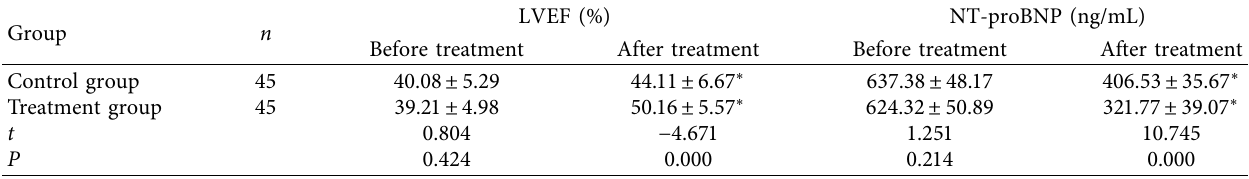
Table 3: Comparison of LVEF and plasma NT-proBNP between the two groups.